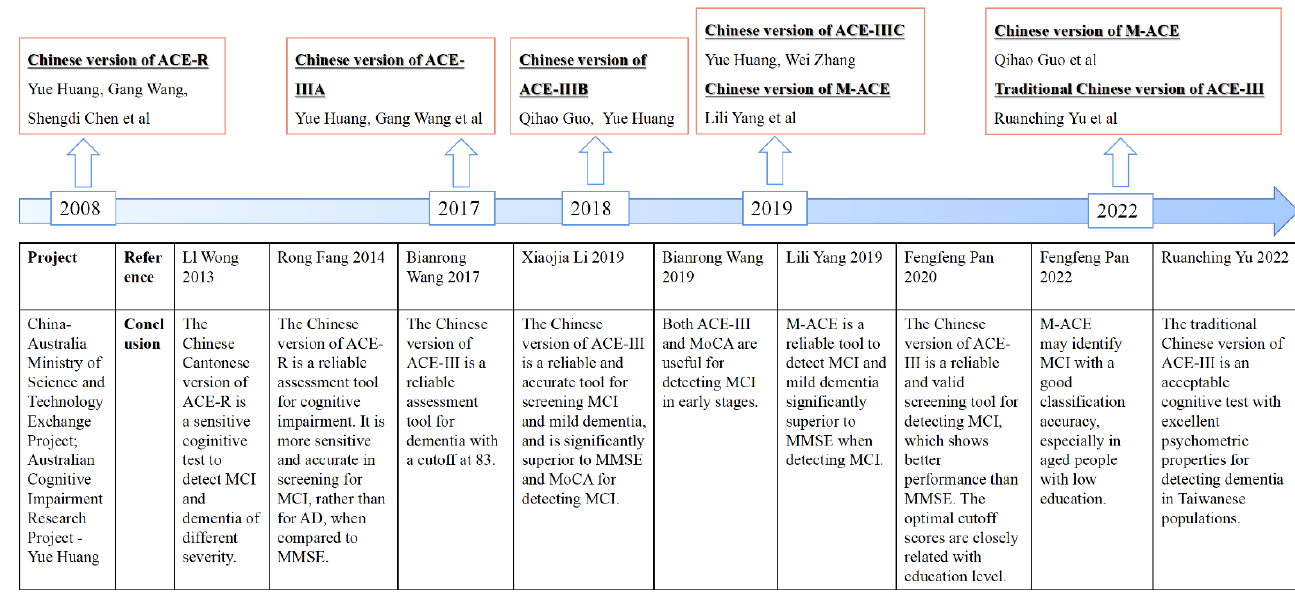
Figure 1. The history of Chinese versions of ACE [23,24,36,37,39,40,42–44]. Abbreviations: ACE, Addenbrooke’s Cognitive Examination; ACE-R, Addenbrooke’s Cognitive Examination-Revised; ACE-III, Addenbrooke’s Cognitive Examination III; M-ACE, Mini-Addenbrooke’s Cognitive Examination; MMSE, Mini-Mental State Examination; MoCA, Montreal Cognitive Assessment; MCI, mild cognitive impairment; AD, Alzheimer’s disease.